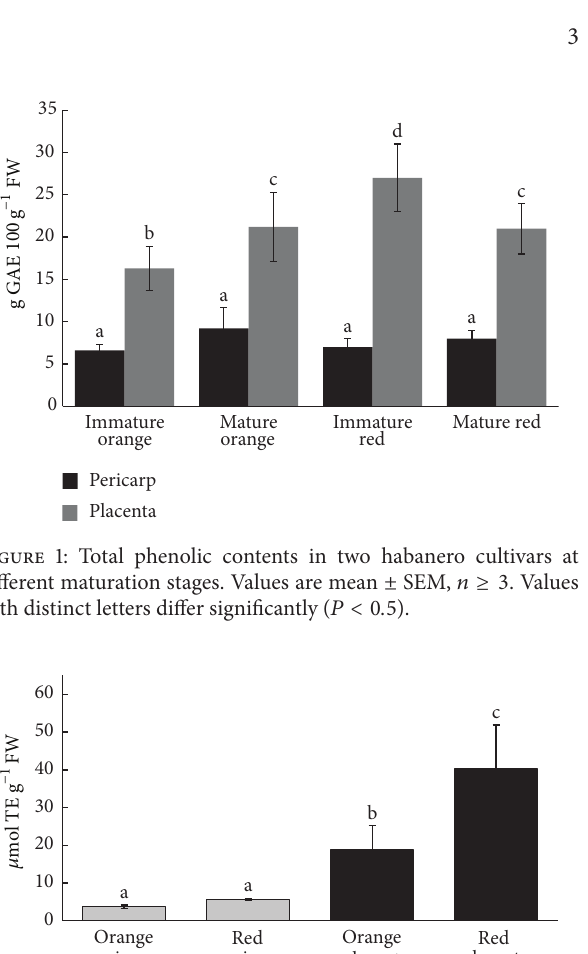
Figure 2: Total CUPRAC antioxidant activity in pericarps and placentas from two immature C. chinense Jacq. accessions. Values are mean ± SEM, 𝑛 ≥ 3 . Differences are significant at level 𝑃 < 0.05